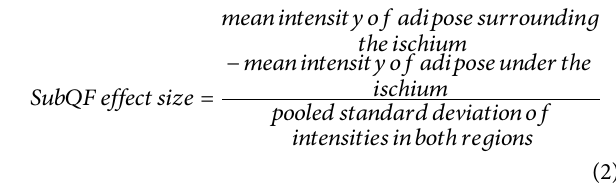
Frontiers in Bioengineering and Biotechnology |